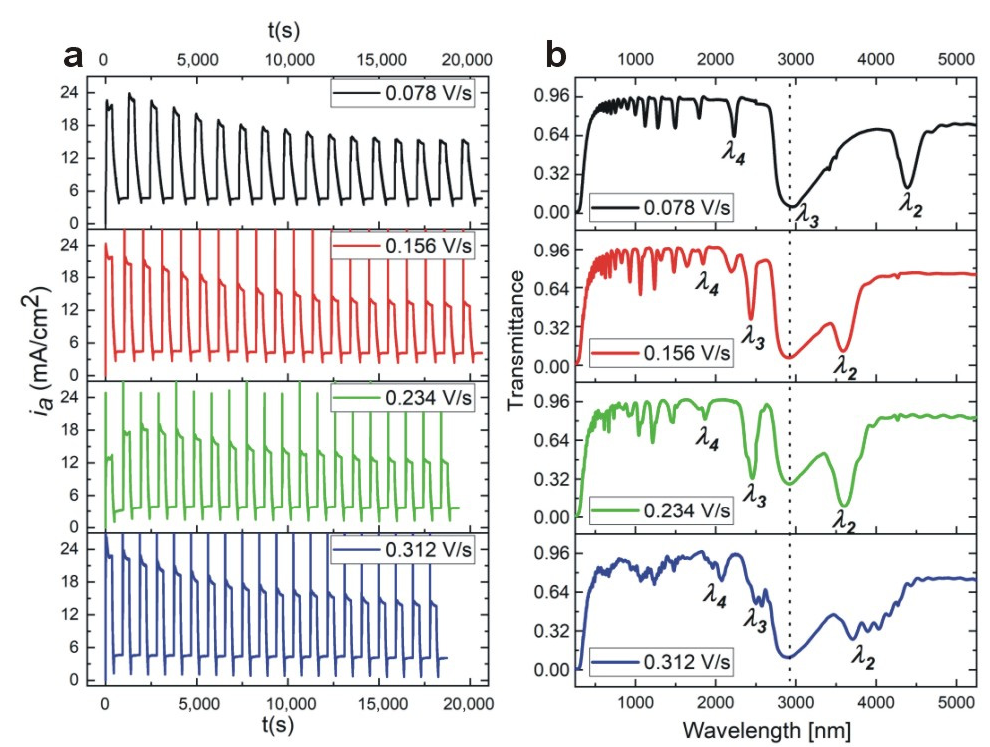
Figure 7. i a ( t ) curves recorded during pulse anodization (U H = 50 V with t H = 360 s, U L = 20 V with t L = 480 s, 20 cycles, at 30 °C) with decreasing U H ̶ ˃ U L drop rate form 0.078 V/s down to 0.312 V/s ( a ), the corresponding transmission spectra (the broad peak at around 3000 nm present in all spectra and marked by vertical, black, dotted line, originate from OH group vibrations of adsorbed water [49]) ( b ).